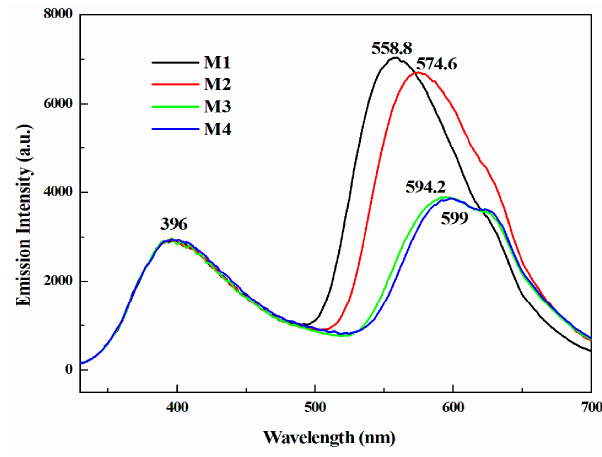
Figure 8. Fluorescence emission spectra of the monomers.